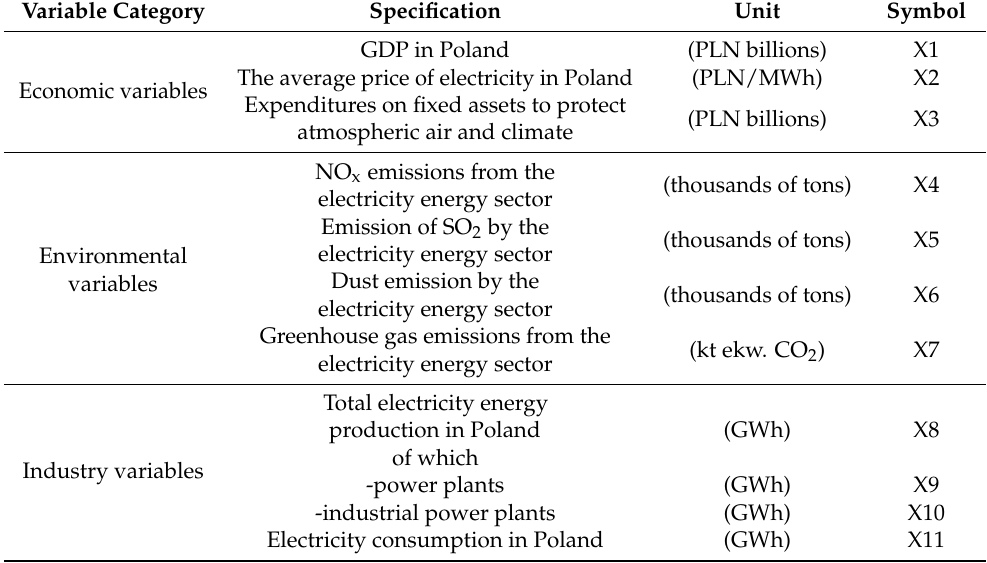
Table 4. Variables used in cause-and-effect